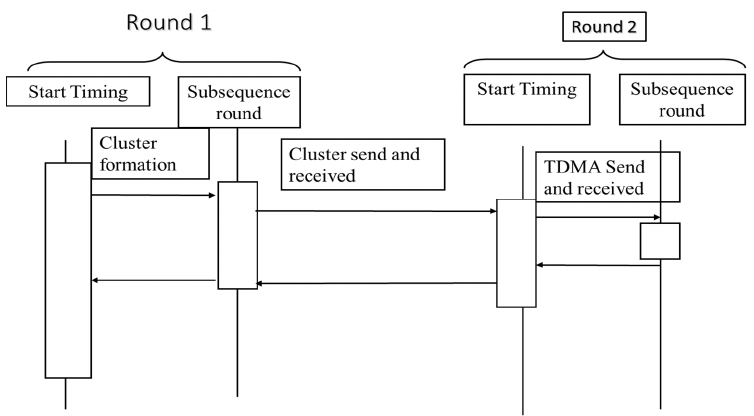
Figure 5. Intelligent Sleeping Mechanism